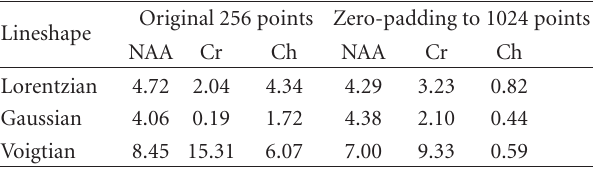
Table 3: Relative errors (%) of spectral fitting of the simulated signal in the frequency domain, caused by truncation e ff ects and by wiggles,